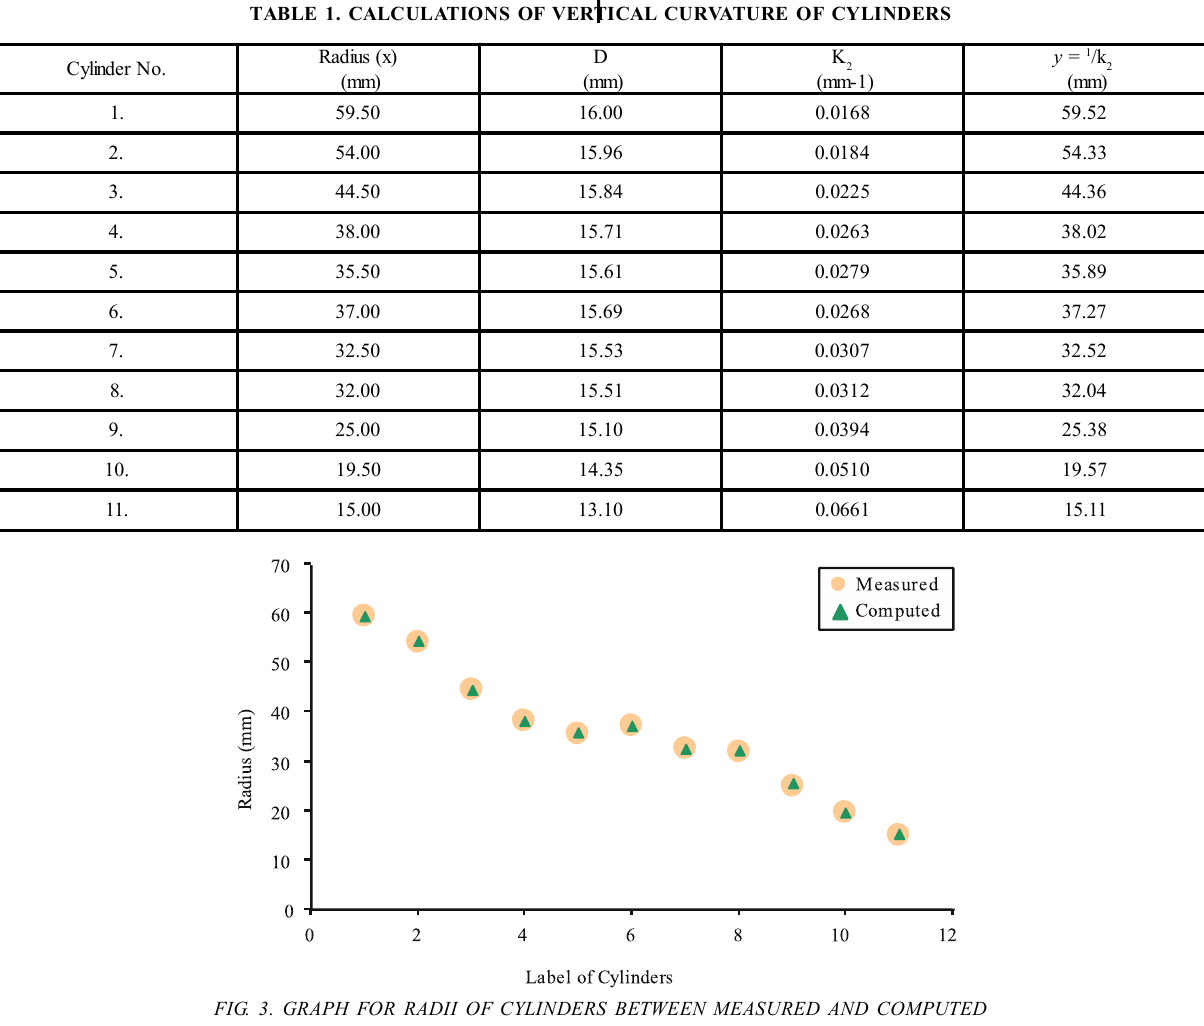
FIG. 3. GRAPH FOR RADII OF CYLINDERS BETWEEN MEASURED AND